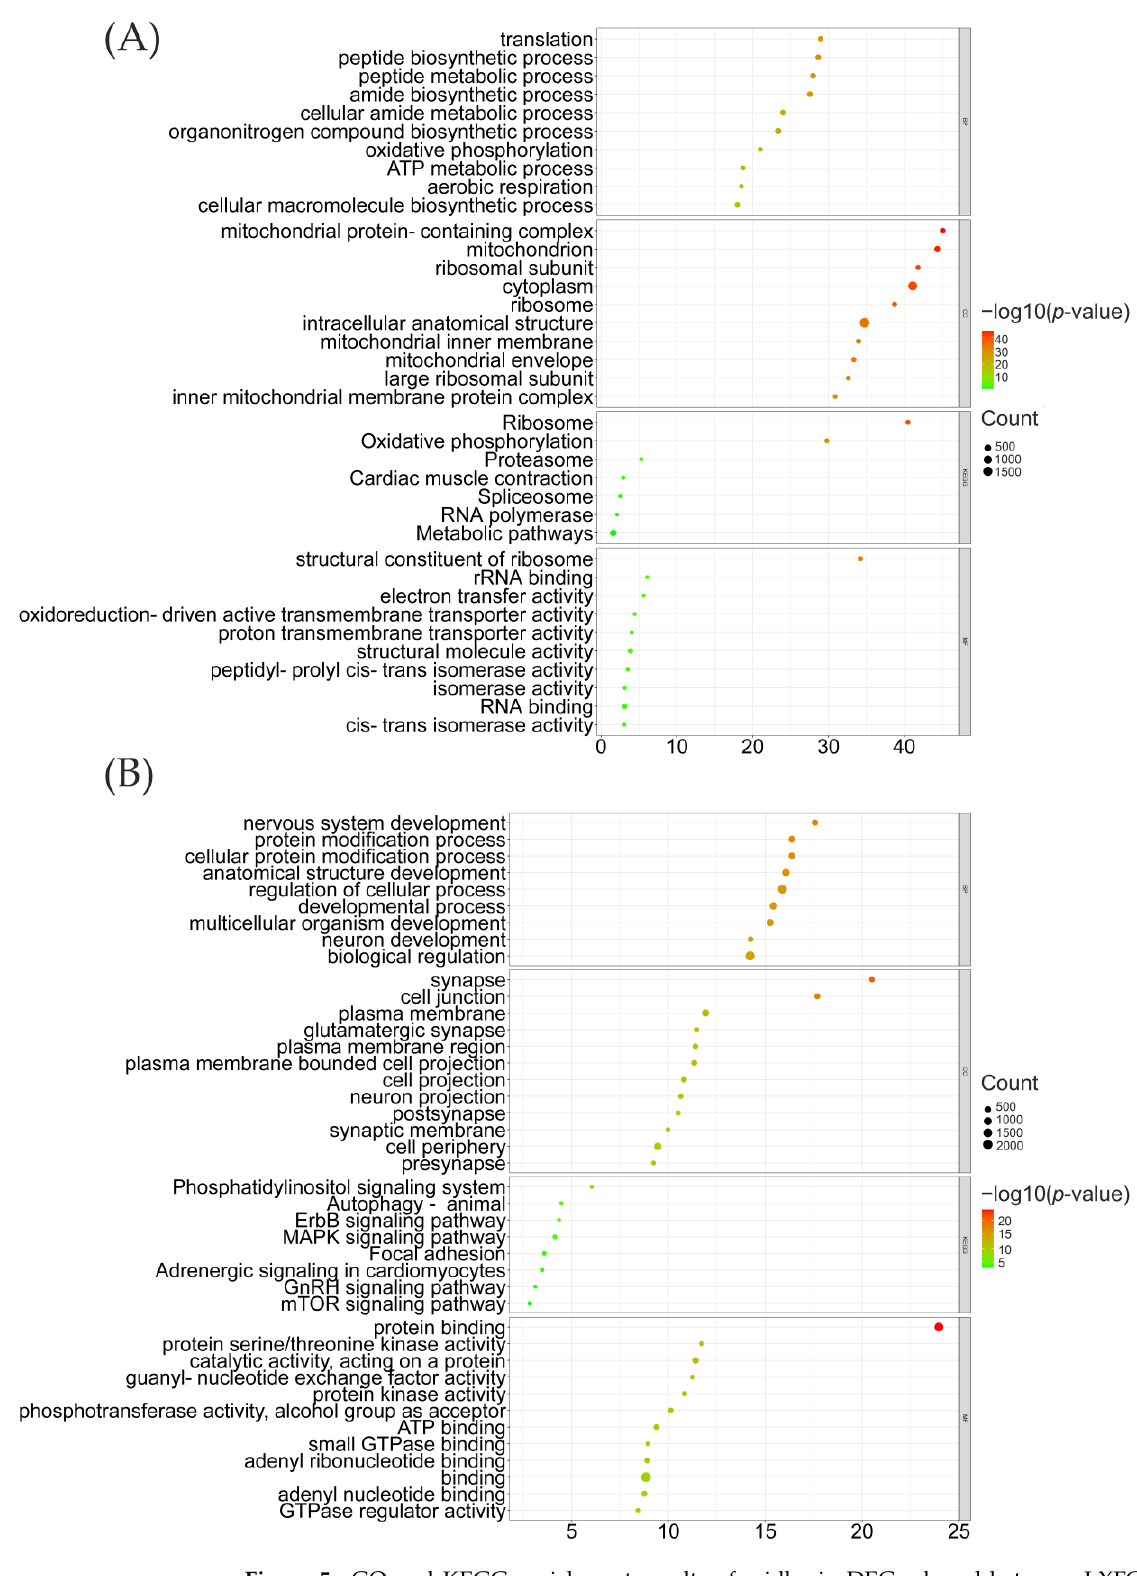
Figure 5. GO and KEGG enrichment results of midbrain DEGs shared between LXFC-TC and LXFC-WL chickens. ( A ) shared down-regulated DEGs ( B ) shared up-regulated DEGs.